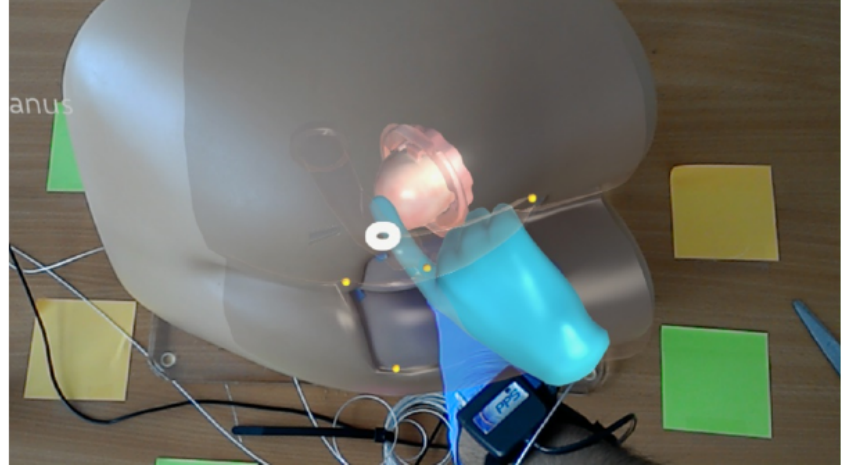
Figure 9. Real-time visualization of digital rectal examination using the proposed augmented reality